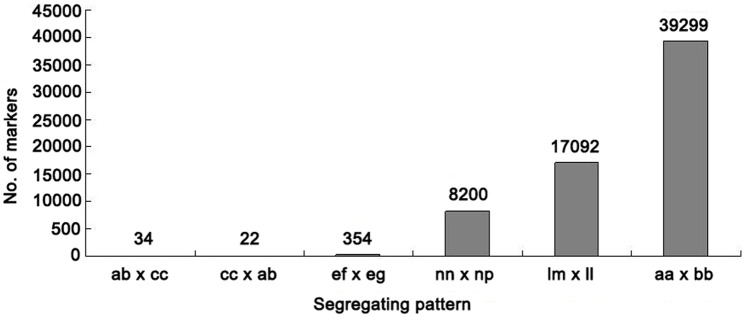
Number of markers for each segregation pattern.